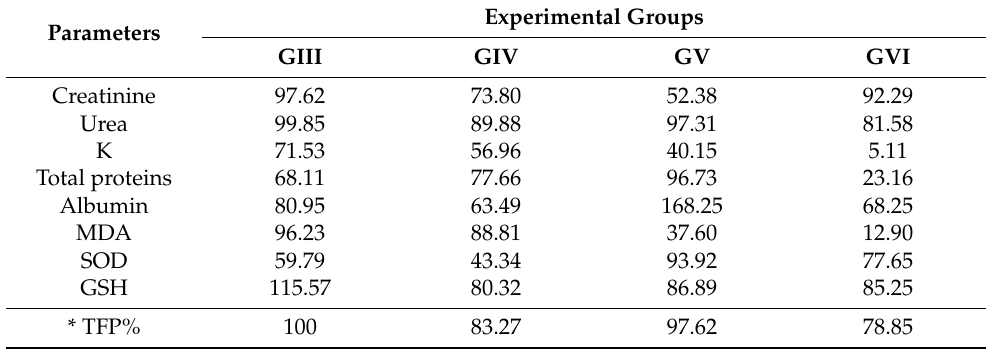
Table 5. Nephroprotection percentage of A. hierochuntica extracts in CCl 4 -induced toxicity in rats.